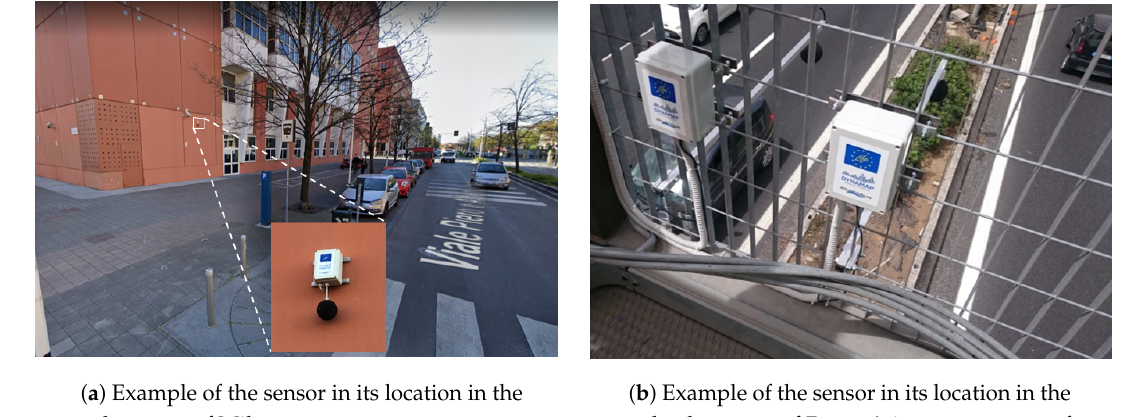
Figure 2. Examples of the location of the low-cost acoustic sensors in the DYNAMAP’s urban and suburban pilot